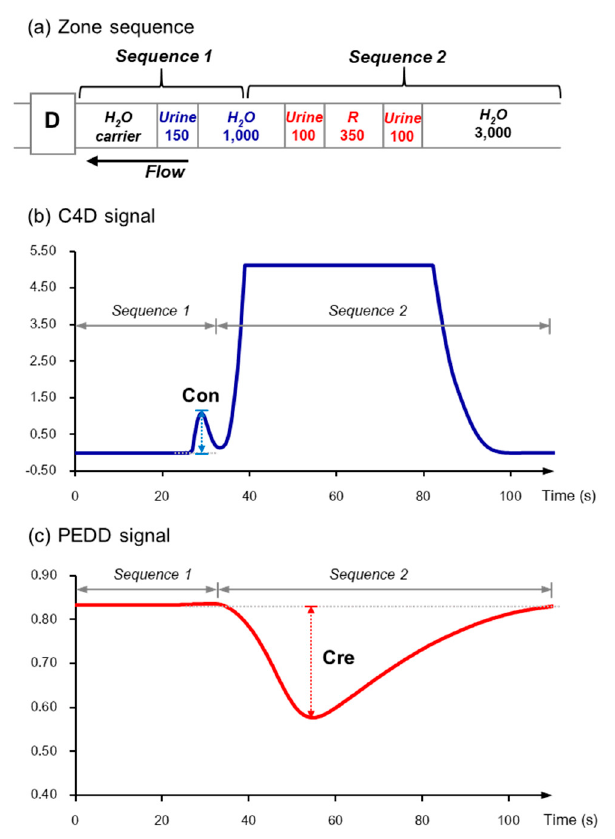
Figure 5. Measurements of urine conductivity and determination of creatinine using SIA equipped with the “2-in-1” C4D-PEDD detector. ( a ) Zone sequence of sample and reagent segments with aspirated volumes in microliters (D: detector). ( b ) Peak profile of urine conductivity (Con) from C4D. The